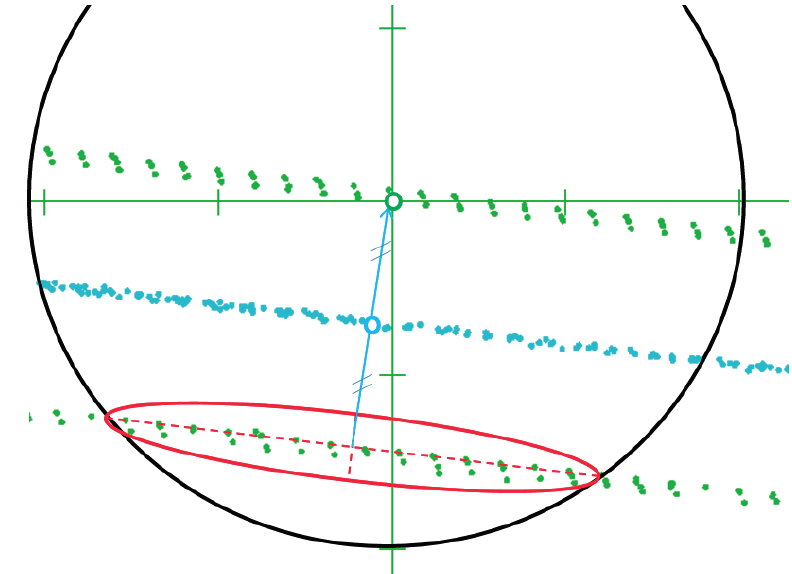
Figure 4. Within a radius of 2 m (black circle), points are selected at the parallel track (red ellipse). The average direction of those points is used to construct a perpendicular line through the current rail track point (green dot). The center point is generated on that line (blue dot), exactly in between the rail track point and line through the selected parallel track points. Next, points are grouped into segments. This holds for both the center points and the rail track